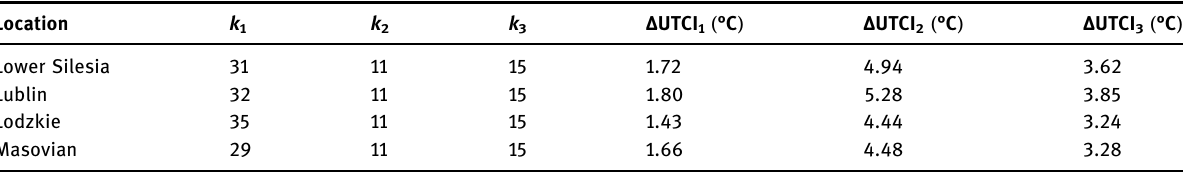
Table 3: The number and length of ranges of classes Location k